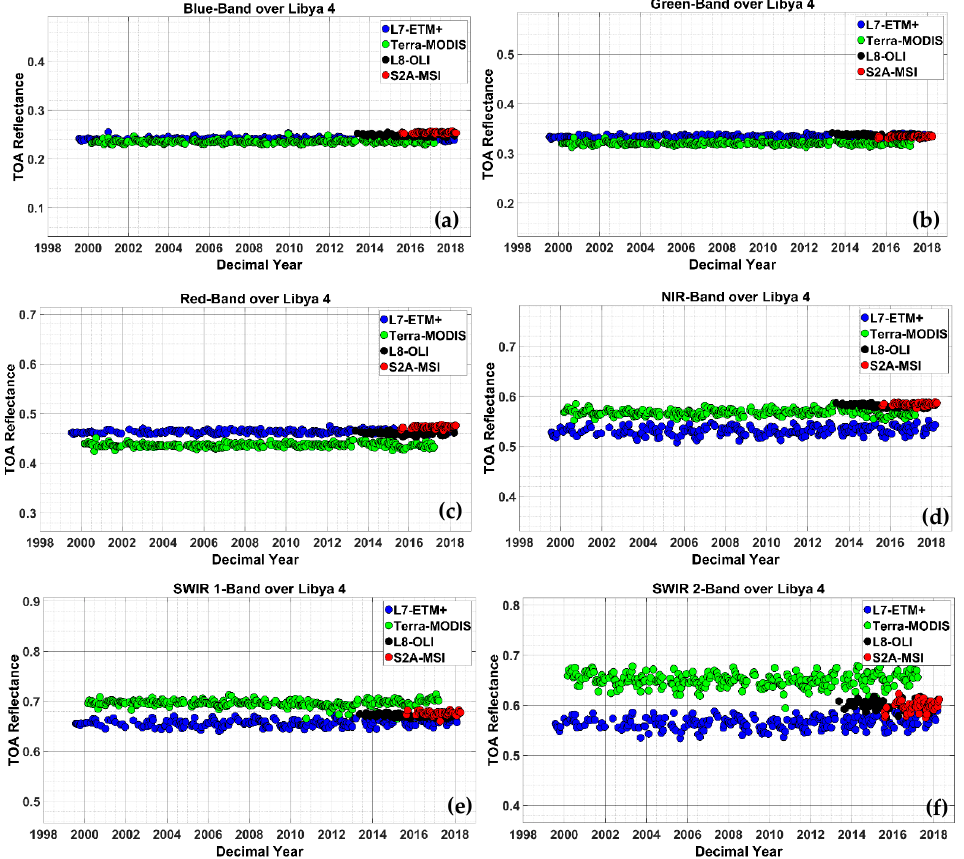
Figure 4. Temporal trend of BRDF-corrected TOA Reflectance over Libya 4 Site [L7 ETM+, Terra MODIS, L8 OLI and S2A MSI]. Blue ( a ), Green ( b ), Red ( c ), NIR ( d ), SWIR 1 ( e ) and SWIR 2 ( f ) spectral bands. Note that in this figure the scaling adjustment factor has not been applied yet.